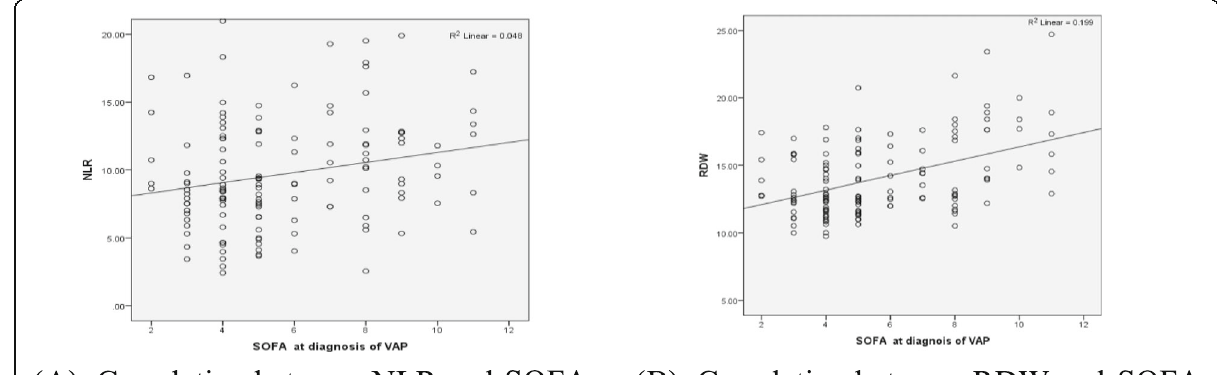
Fig. 5 a Correlation between NLR and SOFA. b Correlation between RDW and SOFA